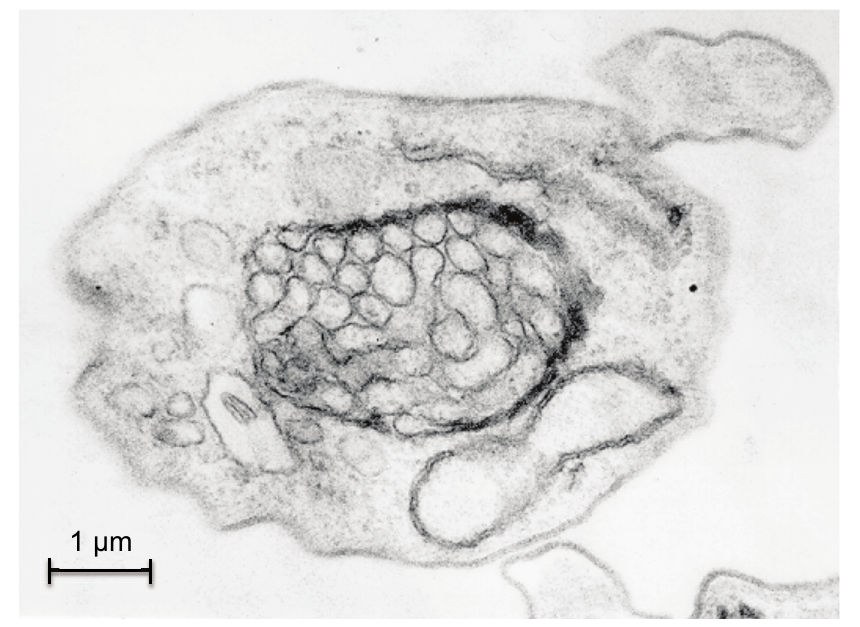
Figure 3. Pexophagy in Trypanosoma brucei . The picture represents a transmission electron micrograph of a cross section of a trypanosome showing an autophagosome-like, double-membrane structure containing multiple